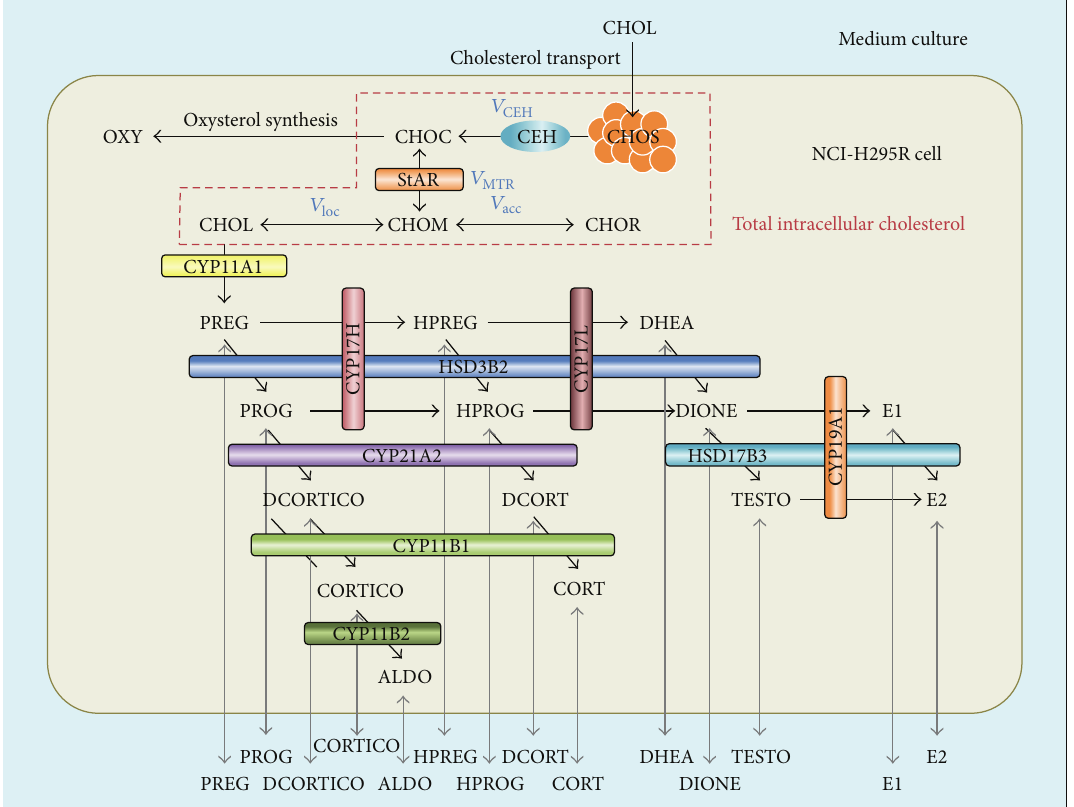
Figure 1: Schematic diagram of the mathematical model of adrenal steroidogenesis in NCI-H295R cells. Overview of the mathematical model of adrenal steroidogenesis in NCI-H295R cells, including cholesterol transport and intracellular localization, oxysterol synthesis, the C 21 -steroid hormone biosynthesis pathway, passive diffusional transport of steroid hormones, and cell proliferation. CHOL: total cholesterol in medium culture, CHOS: stored cholesterol esters in the endoplasmic reticulum, CHOC: intracellular free cholesterol, CHOM: mitochondrial free cholesterol, CHON: mitochondrial free cholesterol close to CYP11A1 enzymes, CHOR: mitochondrial free cholesterol remote from CYP11A1 enzymes, PREG: pregnenolone, HPREG: 17 𝛼 -hydroxypregnenolone, DHEA: dehydroepiandrosterone, PROG: progesterone, HPROG: 17 𝛼 -hydroxyprogesterone, DIONE: androstenedione, DCORTICO: 11-deoxycorticosterone, DCORT: 11- deoxycortisol, CORTICO: corticosterone, CORT: cortisol, ALDO: aldosterone, TESTO: testosterone, E1: estrone, E2: 17 𝛽 -estradiol, OXY: oxysterol, CEH: cholesterol ester hydrolase, StAR: steroidogenic acute regulatory protein, CYP11A1: P450 side chain cleavage enzyme, lyase of CYP17, HSD3B2: 3 𝛽 -hydroxysteroid dehydrogenase, CYP21A2: 21-hydroxylase, CYP17H: 17 𝛼 -hydroxylase of CYP17, CYP17L: C 17 – 20 CYP11B1: 11 𝛽 -hydroxylase, CYP11B2: 18-hydroxylase, HSD17B3: 17 𝛽 -hydroxysteroid dehydrogenase, and CYP19A1: